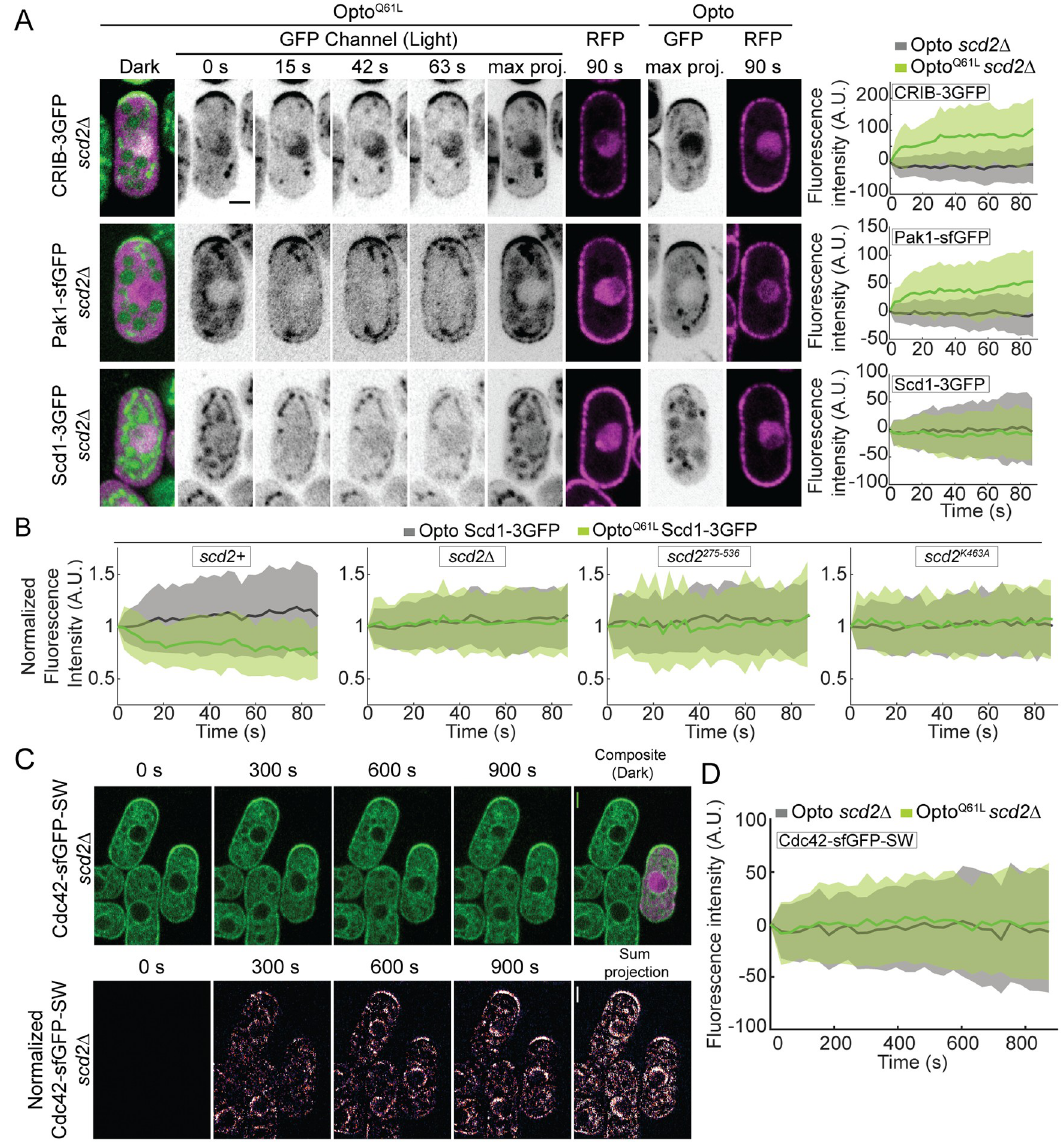
Fig 4. Scd2 is essential for the Cdc42-GTP-triggered positive feedback. (A) In scd2 Δ cells, Opto Q61L induces CRIB and Pak1 recruitment but fails to recruit its GEF Scd1. Data layout as in Fig 3C. N = 3; n > 20 cells per experiment; p CRIB-3GFP = 1.4e -18 ; p Pak1-sfGFP = 8.4e -15 ; p Scd1-3GFP = 0.2. (B) Scd1-3GFP signal at cell tips over time in Opto Q61L and Opto scd2+ ( p = 1.6e -09 ), scd2 Δ ( p = 0.5), scd2 275-536 ( p = 0.1), and scd2 K463A cells ( p = 0.8). N = 3; n > 15 cells. (C) Mixtures of scd2 Δ Opto Q61L (purple) and scd2 Δ control cell expressing Cdc42-sfGFP SW . Data presented as in Fig 3H. Note that there is little change in Cdc42-sfGFP SW distribution in scd2 Δ Opto Q61L cells. (D) Opto Q61L fails to induce cell-side accumulation of endogenous Cdc42-sfGFP SW in scd2 Δ cells. N = 3; n > 20 cells per experiment; p = 0.32. Bars = 2 μ m. All underlying numerical values are available in S4 Data. A.U., arbitrary units; max proj., maximum projection. of Scd1 (Fig 4A, S6A Fig, S4 Movie). Because the Scd1 cortical signal is weak in scd2 Δ cells, we were concerned that we may fail to detect low levels of Scd1 at cell sides. We thus also assessed whether Scd1 from cell tips was depleted by Opto Q61L side recruitment, which would indicate competition (Fig 4B). In contrast to the situation in scd2+ cells, upon Opto Q61L activation in scd2 Δ mutants, Scd1-3GFP tip levels remained constant, supporting the notion that Scd1 does not relocalize in these cells. Similarly, endogenous Cdc42-sfGFP SW protein did not change